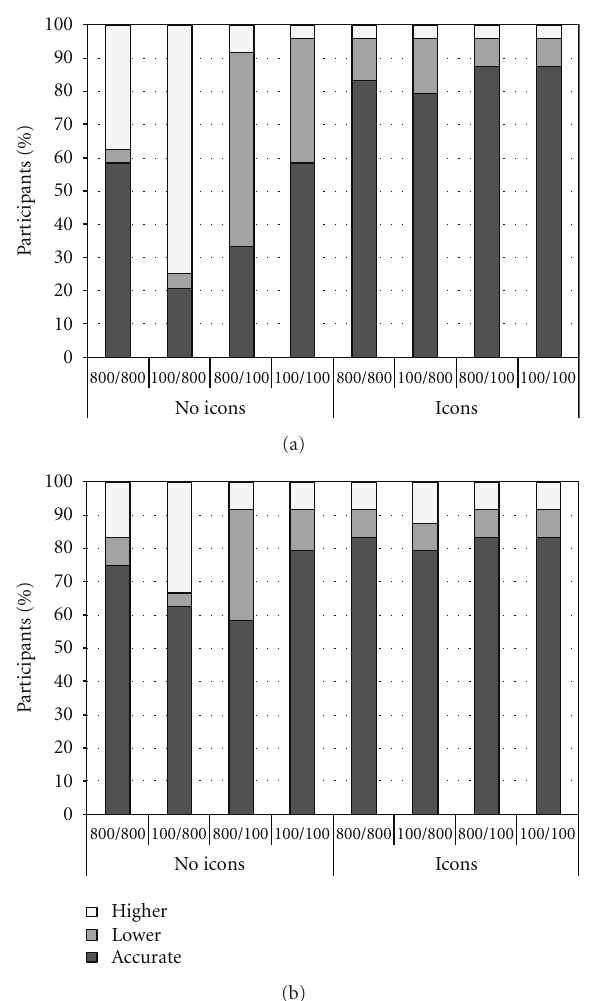
Figure 3: (a) Percentage of participants whose estimates of risk reduction were accurate, lower, or higher than the exact value as a function of the sizes of the denominators and icon arrays when information about risk reduction was provided in English . (b) Percentage of participants whose estimates of risk reduction were accurate, lower, or higher than the exact value as a function of the sizes of the denominators and icon arrays when information about risk reduction was provided in Polish